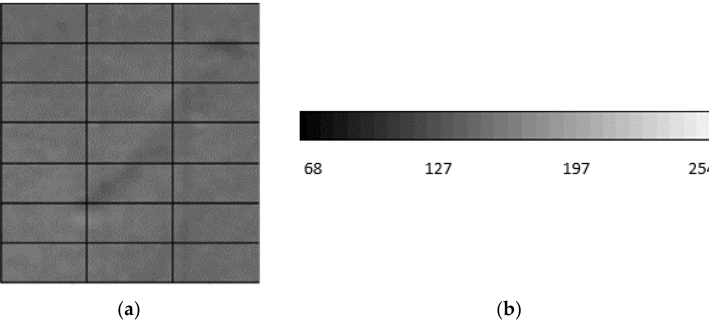
Figure 14. Defect detection of the hot-rolling mill (processed in Ametek): ( a ) defect detected at hot-rolling mill; ( b ) pixels shade scale.